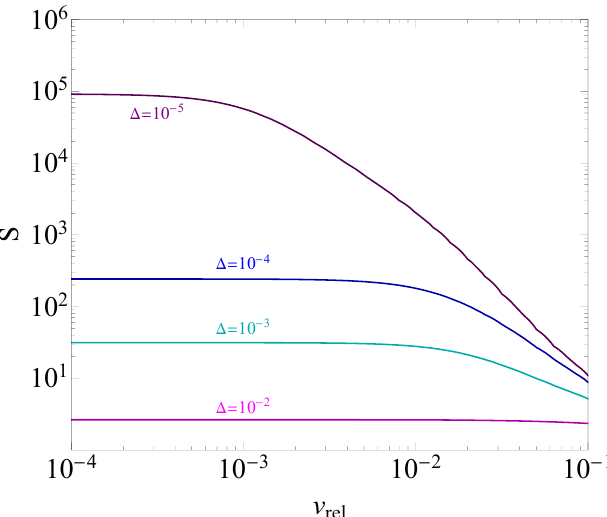
Figure 2 . Sommerfeld factor for s -wave elastic scattering, φ 1 φ 2 → φ 1 φ 2 , as a function of the relative velocity v rel . We chose α = g 2 / (4 π ) = 0 . 1 and ∆ = 10 − 2 , 10 − 3 , 10 − 4 , 10 − 5 , for m 2 = 2 m 1 (1 − ∆) , in the lines from bottom to